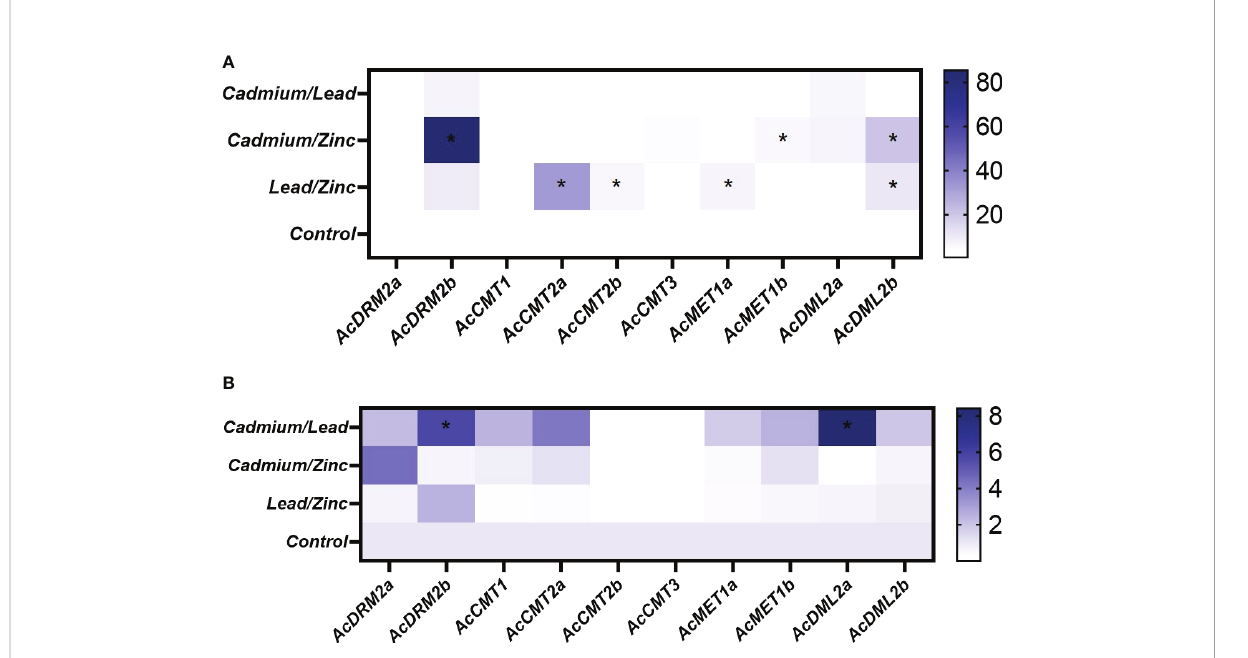
FIGURE 7 Heatmap representation of relative expression data for A. cruentus MTase and DMTase genes in the root (A) and leaf (B) tissues under the combined HM stress; asterisks in heatmap show statistical signi fi cance at p < 0.05 based on Tukey ’ s test when comparing HM-treated and control plants. The white and blue scale indicate relative expression to control samples where the expression level was set to